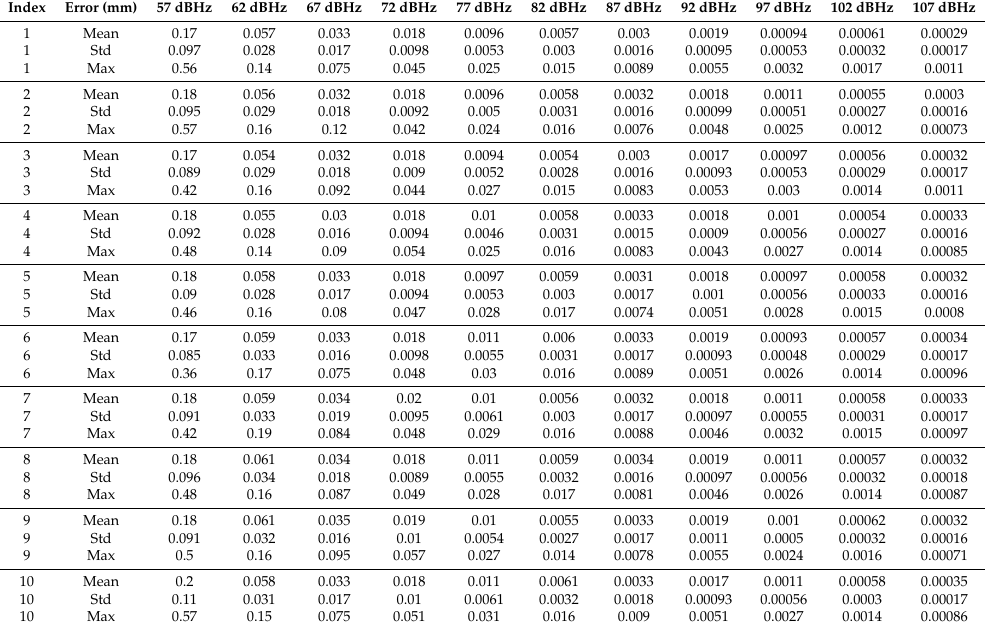
Table A6. Mean values, standard deviation, and maximum error values in the calculation of the impact point using FDMA-FFT with a 8-bit